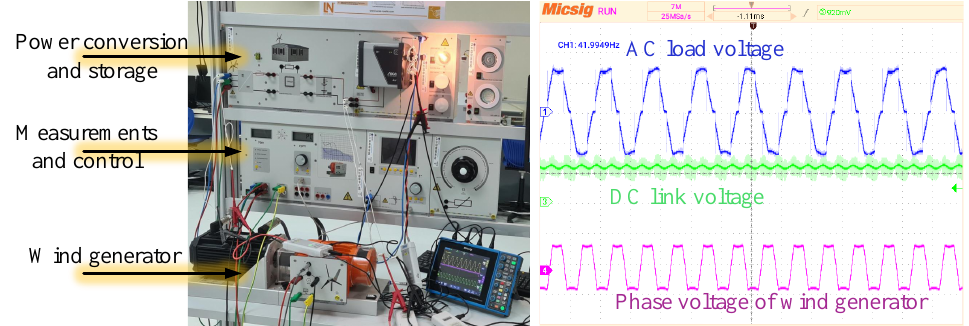
Figure 15. Experimental results for three-phase full − wave rectification used in small wind turbine